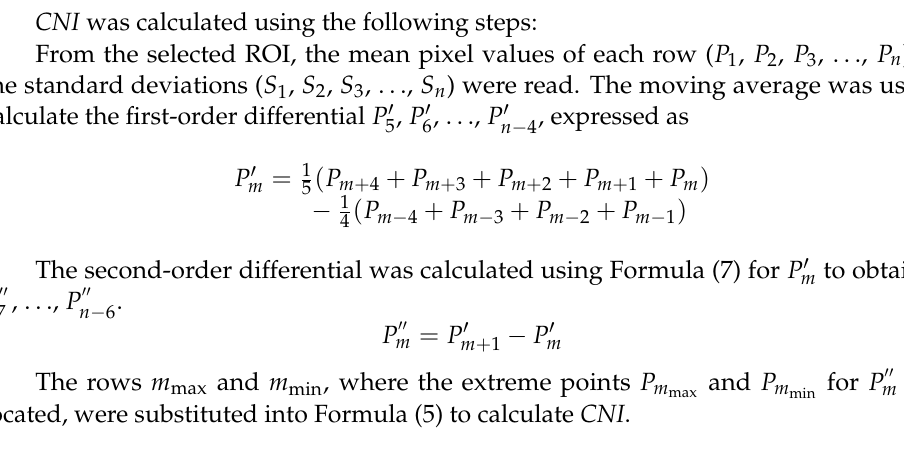
Figure 3. An example of locating and delineating the ROI for the CNRI.